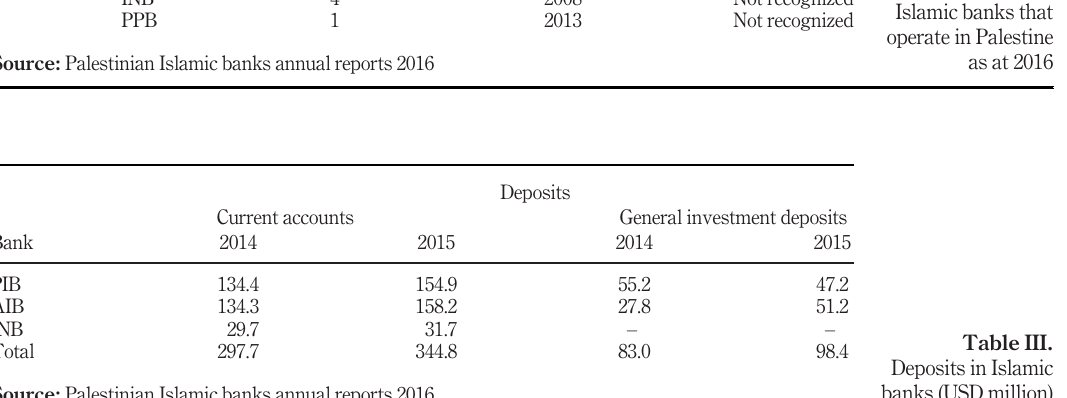
Table II. Islamic banks that